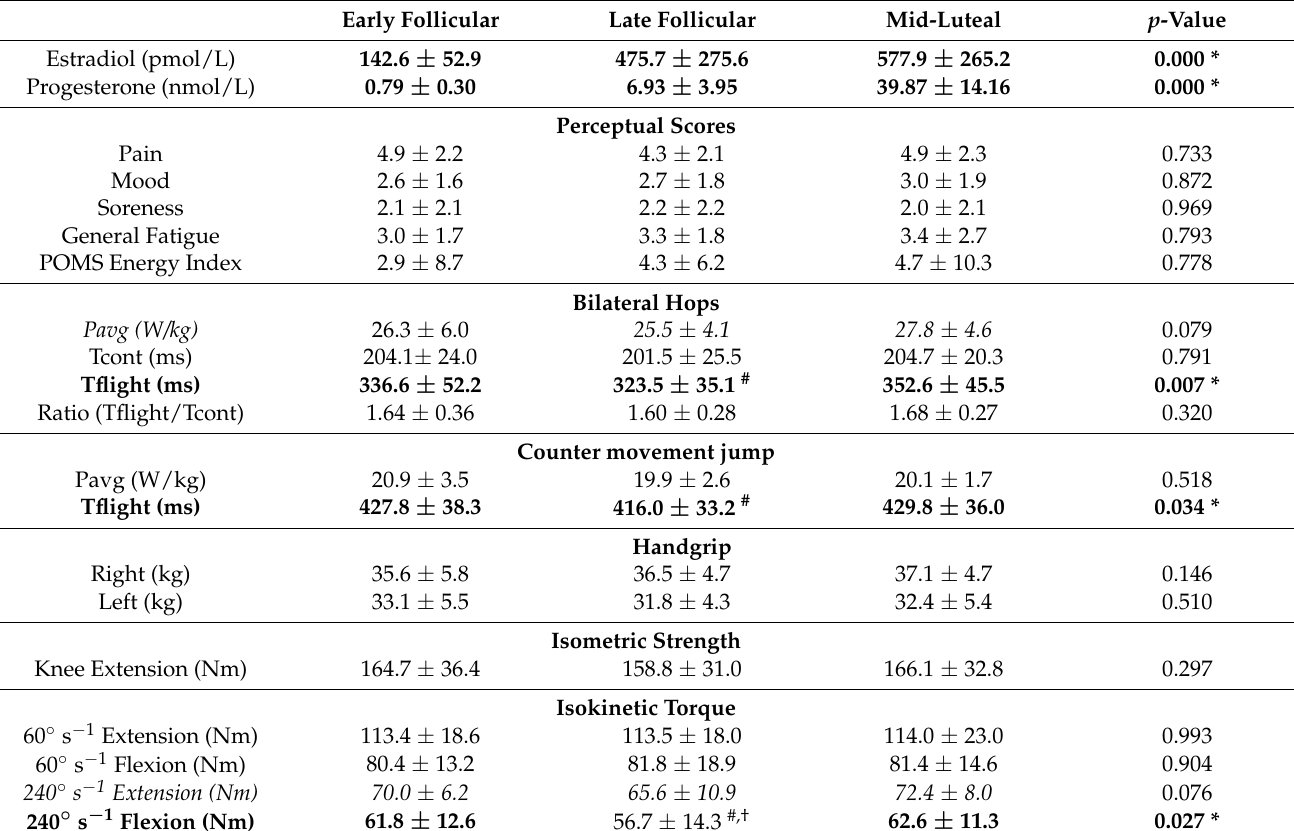
Table 1. Hormone concentrations, perceptual and muscle function measures for the Menstrual Cycle group ( n = 10) over the three phases of the menstrual cycle. Early Follicular Late Follicular Mid-Luteal p